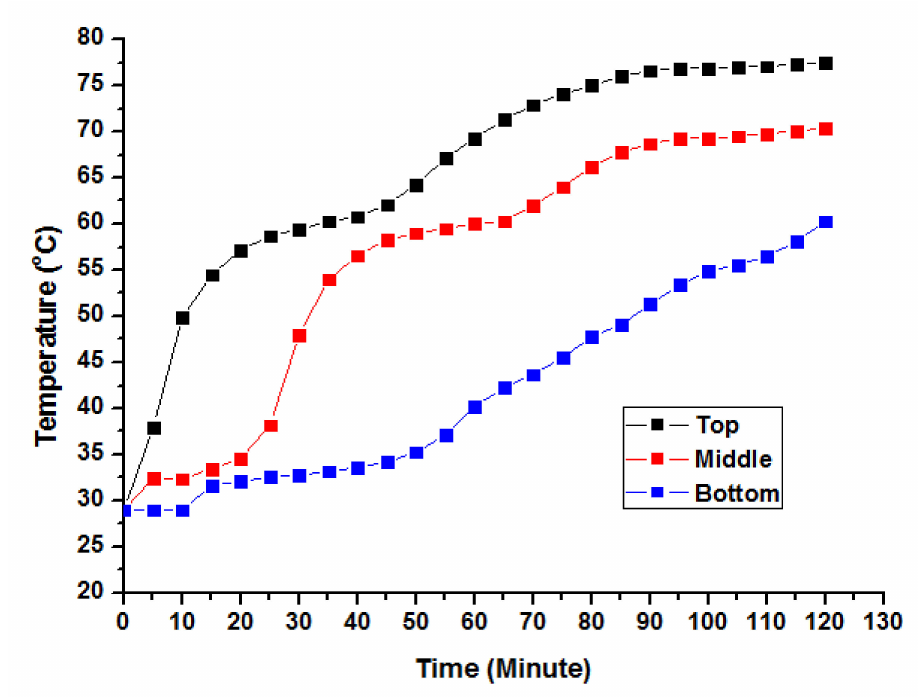
Figure 14. Temperature changes of water in the thermal storage